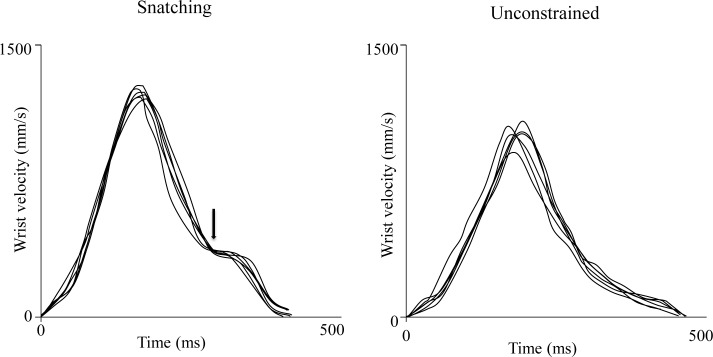
Superimposition of the velocity profiles for the snatching and the unconstrained conditions for the six individuals considered.This figure well represents how stereotypical this type of movements was with specific reference to the break point occurring along the deceleration phase. The arrow indicates the beginning of the break point.